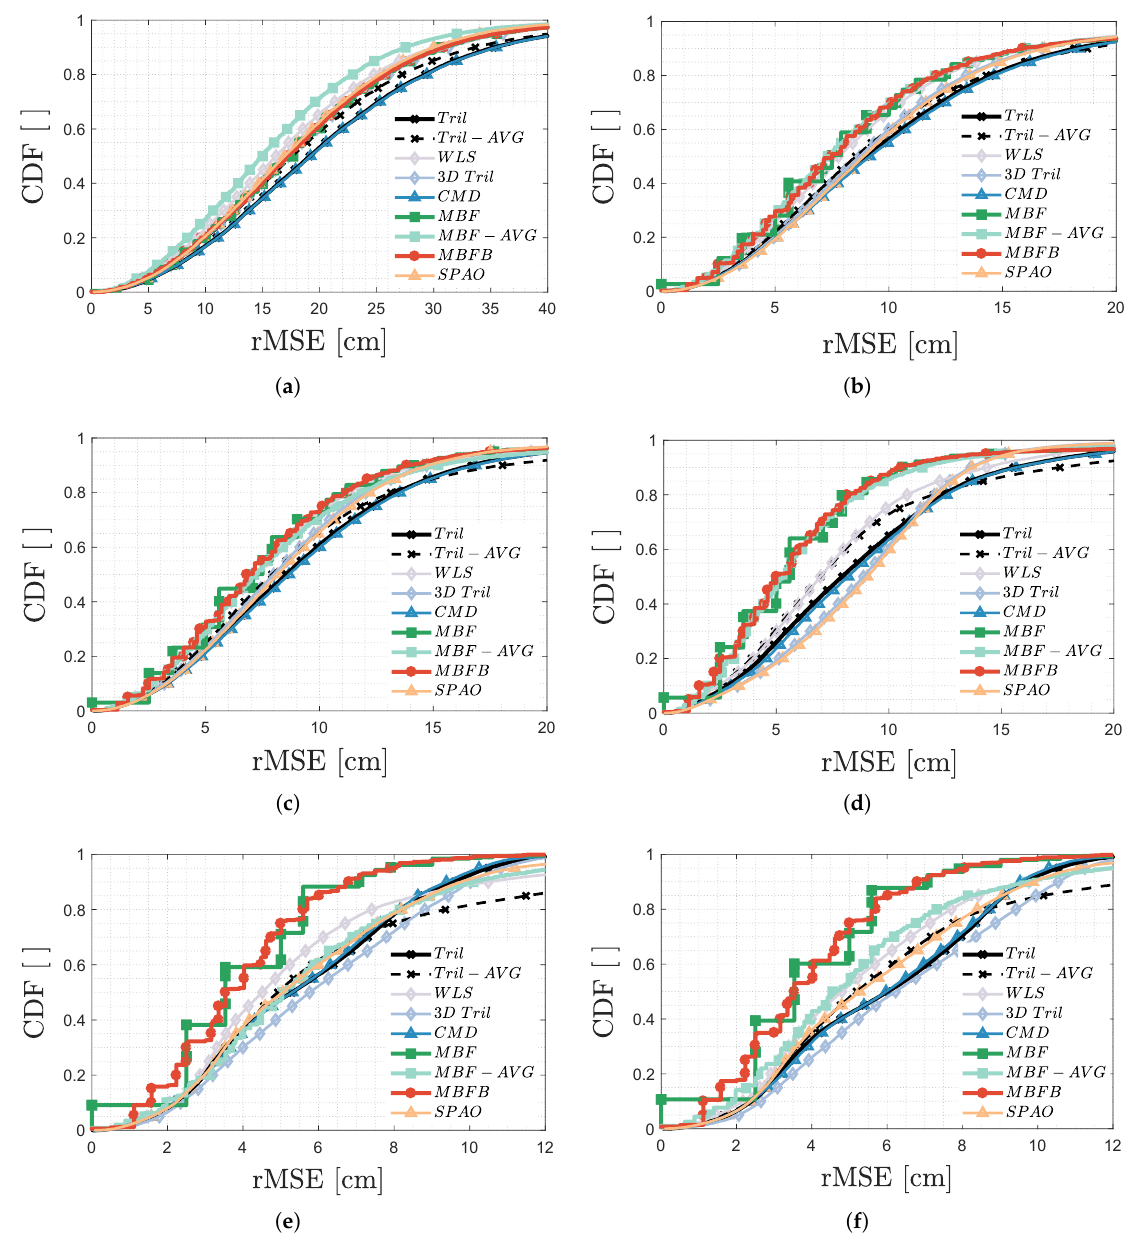
Figure 14. Cumulative distribution function (CDF) of the rMSE appertaining to the positioning algorithms of Section 2.5 in the case of uVLP in combination with ( a ) S, ( b ) C-FPh, ( c ) P and ( d ) P-PdF demodulation, and of VLP with ( e ) S and ( f )